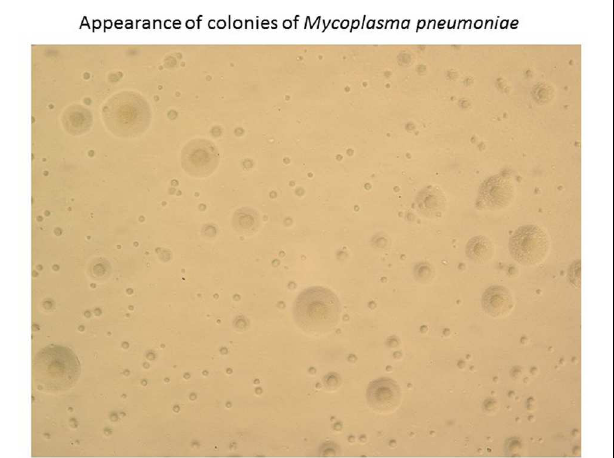
FIGURE 2 | Appearance of colonies of Mycoplasma pneumoniae. Colonies of M. pneumoniae on an agar plate typically have a unique “fried egg”